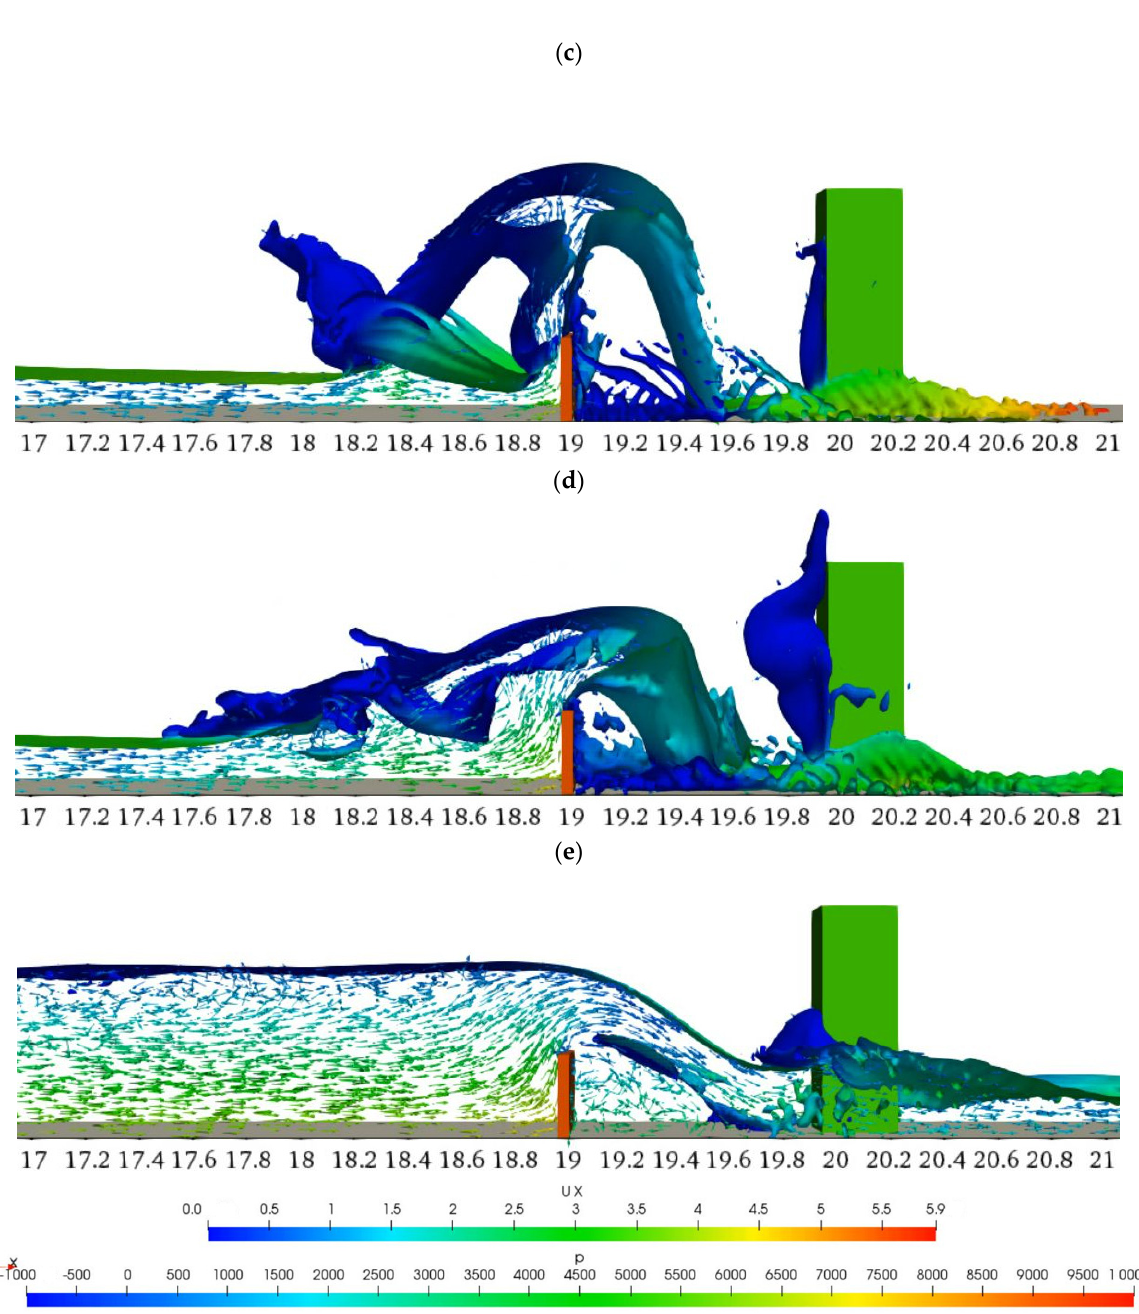
Figure 11. Flow interaction with the inland structure at different time instances in the presence of a VW d o = 0.9 m, L = 1 m and Wall 4. (Ux-Surge velocity in the x -direction in m/s; P- pressure in N/m 2 ). Vectors are colored with pressure, and the free surface is colored with Ux. The numbers in the images represent the distance in the x-direction from the tank origin in meters: ( a ) t ( g/d o ) 0.5 = 7.92; ( b ) t ( g/d o ) 0.5 = 9.57; ( c ) t ( g/d o ) 0.5 = 11.06 ( t C ); ( d ) t ( g/d o ) 0.5 = 12.71 ( t D ); ( e ) t ( g/d o ) 0.5 = 25.58 ( t E ).